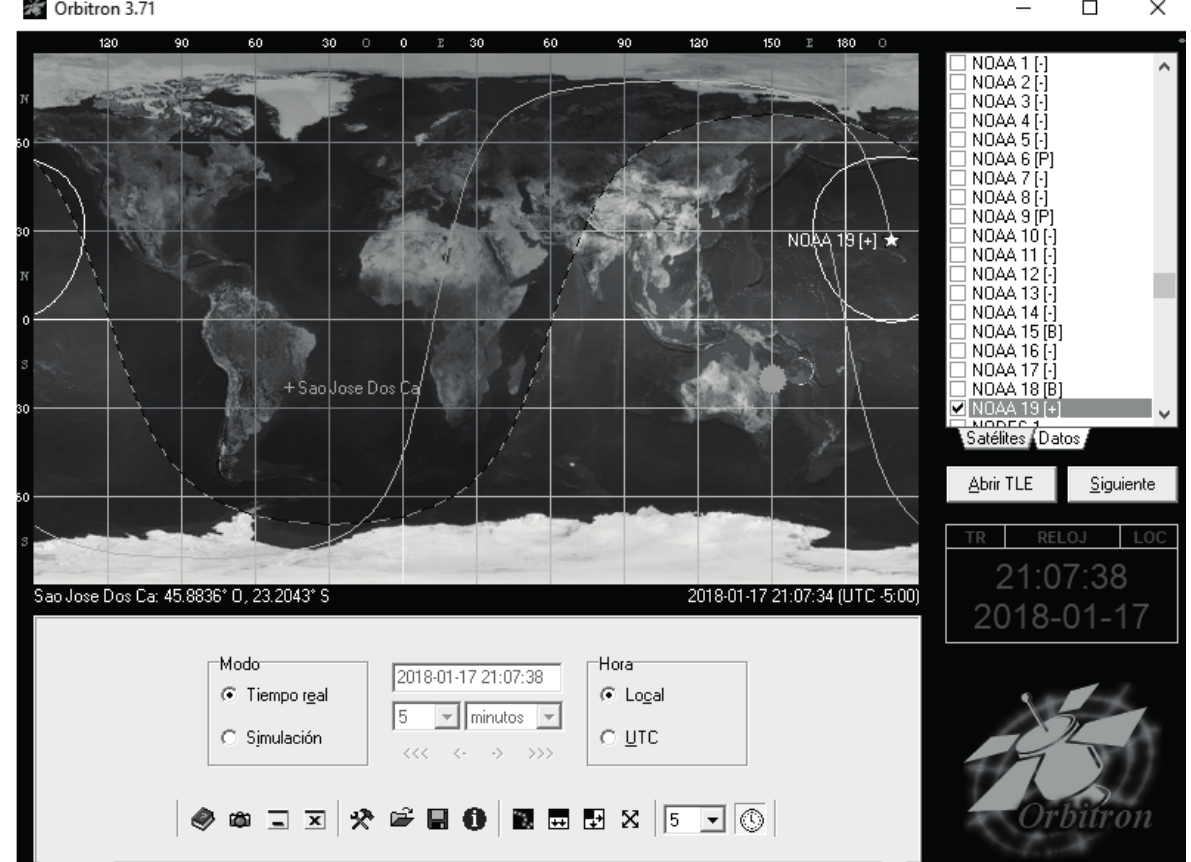
Figure 3 - Orbitron screenshot with satellite tracking